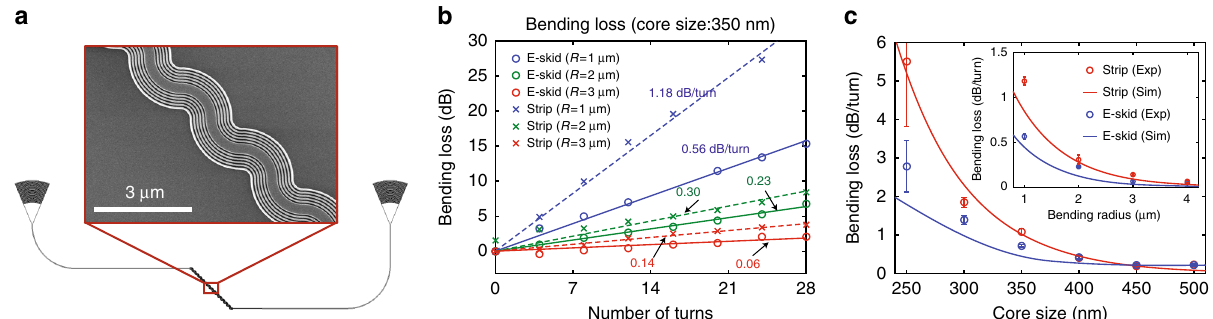
Fig. 6 Bending loss in e-skid waveguides. a Layout and zoomed-in SEM images of the test devices to characterize the bending loss. b Measured bending losses with different number of turns; circles and crosses are the e-skid and strip waveguides, respectively, and blue, green, and red are at different bending radiuses of R = 1, 2, and 3 μ m. Each experimental result is fi tted with a linear line: e-skid (solid) and strip (dashed) lines. The core size is w 0 ¼ 350 nm. c Characterized bending loss vs. core size ( R ¼ 1 μ m): e-skid (red) and strip (blue) waveguides. Inset shows the characterized bending loss vs. bending radius ( w 0 ¼ 350 nm). Red and blue lines are the simulated bending losses of the e-skid and strip waveguides, respectively. Error bars represent the standard deviation of the fi tting curves. Other parameters ( h 0 ; Λ ; ρ ; N , and λ ) are the same as in Fig. 3. Con fi nement of the evanescent waves in e-skid waveguides due to the metamaterial cladding helps to reduce the bending loss at sharp bends in photonic-integrated circuits. This effect is stronger for waveguides with smaller core sizes, as a considerable amount of the power lies outside the core and